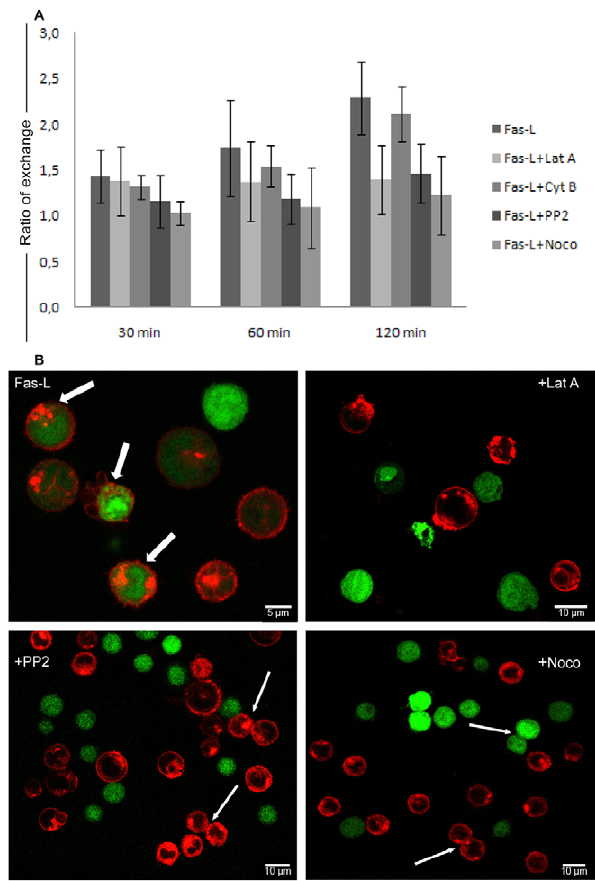
Figure 4. Intercellular exchange of endocytic vesicles DiI- labelled between CD4 + T cells. Bar diagram represent the time- course of DiI transfer, quantified by flow cytometry, after FasL administration and pre-treatment with different pharmacological inhibitors (A). DiI uptake by green cells shows a growing trend over time, which is strongly reduced by Noco treatment, indicating a main involvement of microtubules. The data are a representation of 6 independent experiments and have been expressed as ratio of MFI on treated cells divided by that recorded in untreated cells. Confocal microscopy (B) of cells labelled with CFSE (green) and DiI (red) separately support the cytometric data for both dyes exchange (Figs. 3 and 4A). The image of FasL stimulated cells revealed most ‘‘double positive’’ cells (thick arrows) that are decreased or even absent after pre-treatment with Lat A (latrunculin A) or PP2 or Noco (nocodazole), although some cell conjugates are still present (thin arrows).